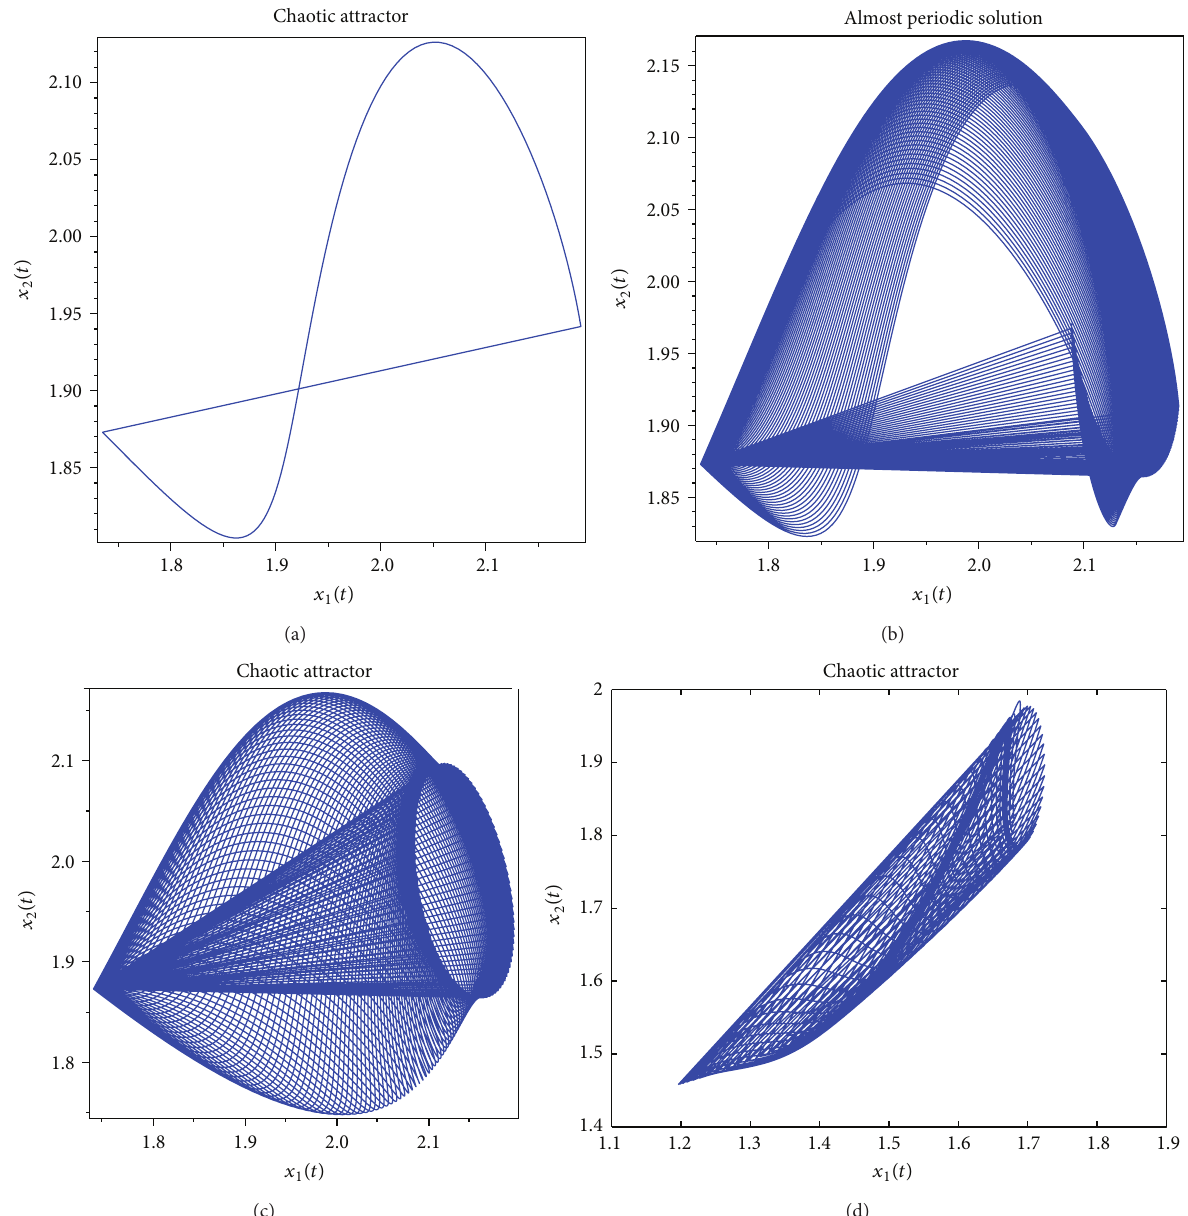
Figure 3: (a), (b), (c), and (d) Dynamical behavior of system (4). Here, we take the initial value 𝑥 0 = (𝑥 10 , 𝑥 20 ) = (1.735, 1.873).